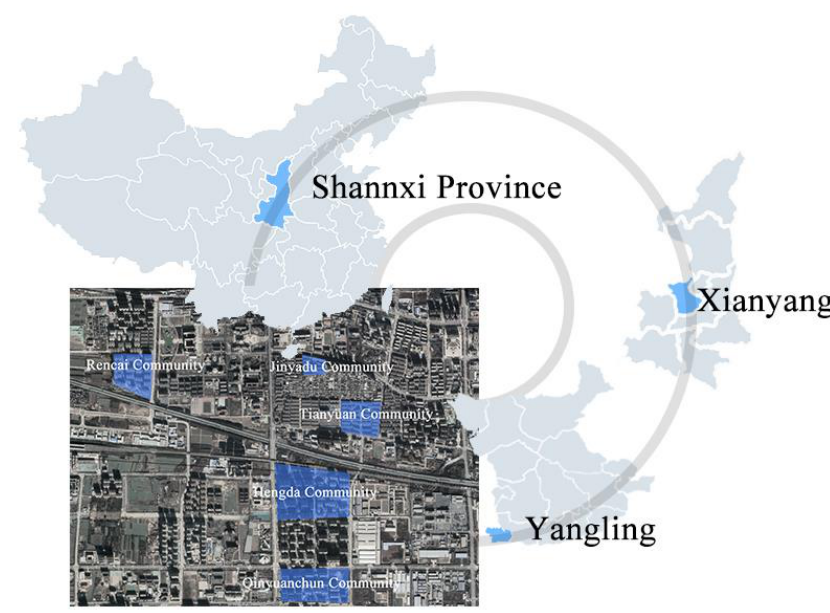
Figure 1. The geographic location of cases of residential communities.